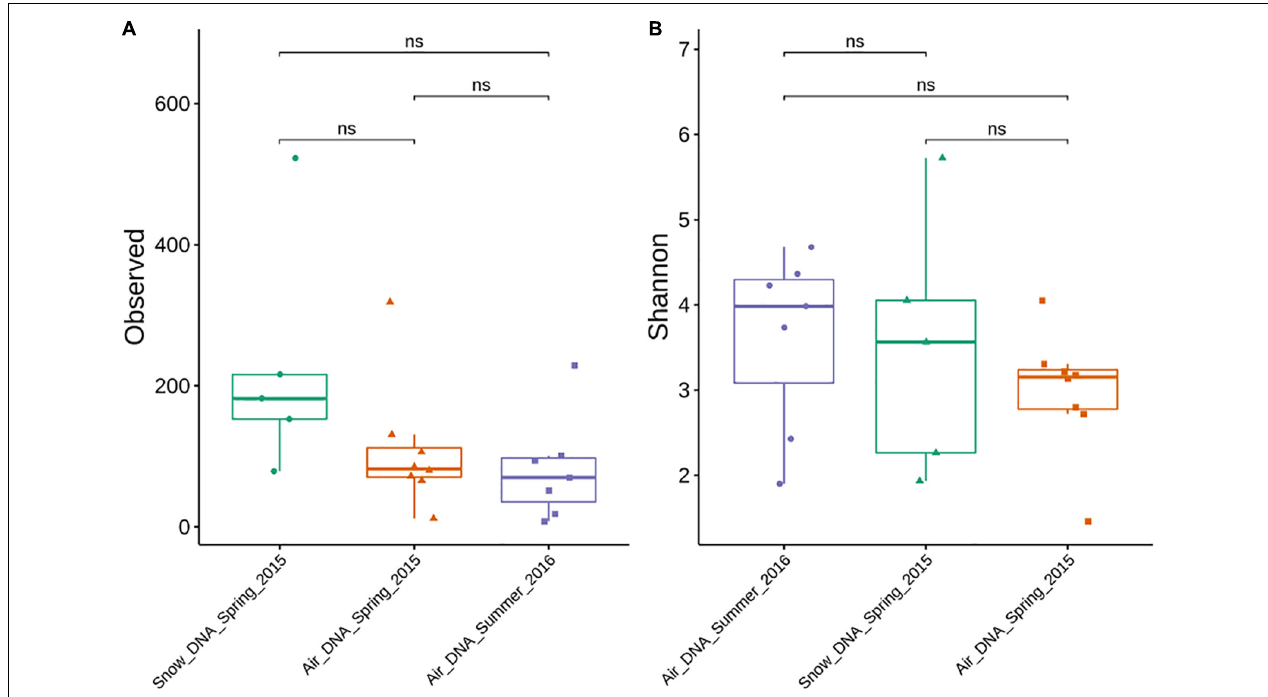
FIGURE 1 | Alpha diversity (ASV richness and Shannon index) of DNA-level air and snow bacterial communities sampled during spring and summer. Significant differences between sample types were evaluated by a Kruskal-Wallis rank-sum test. Significance is denoted as: ns, nonsignificant as p > 0.05. (A) Observed ASV richness. (B) Shannon